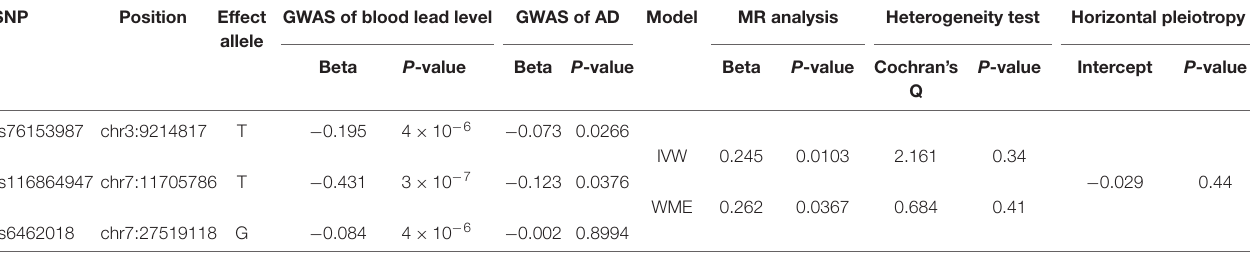
TABLE 1 | The causality of blood lead level and Alzheimer’s disease (AD) risk by two-sample Mendelian randomization (MR) analysis using the data of AD consortium (Kunkle et al., 2019). SNP Position